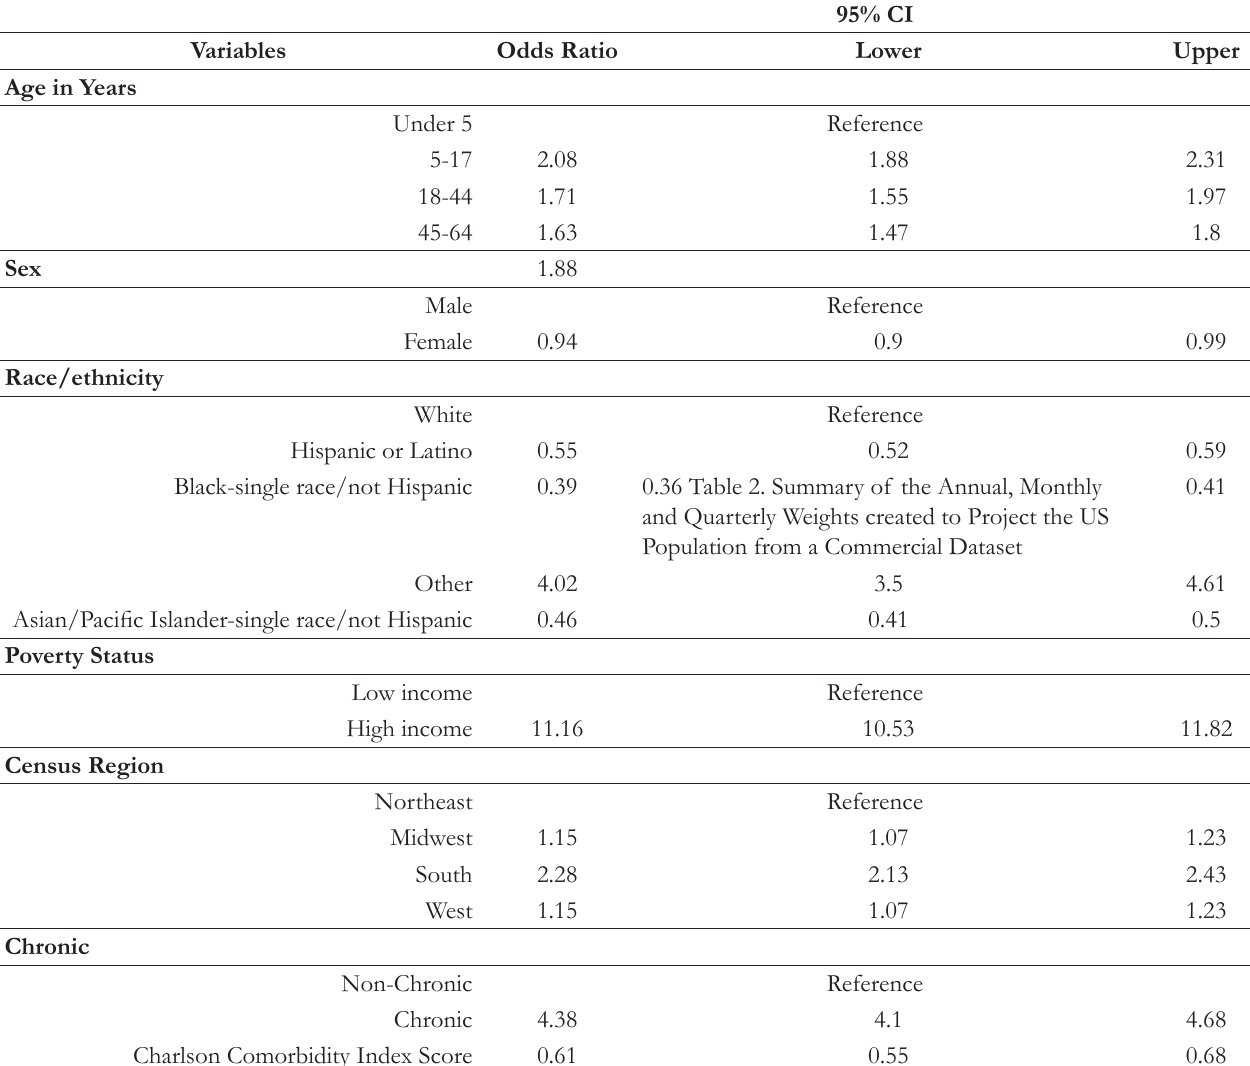
Table 1. Socioeconomic and Clinical Factor Differences in Commercial and MEPS